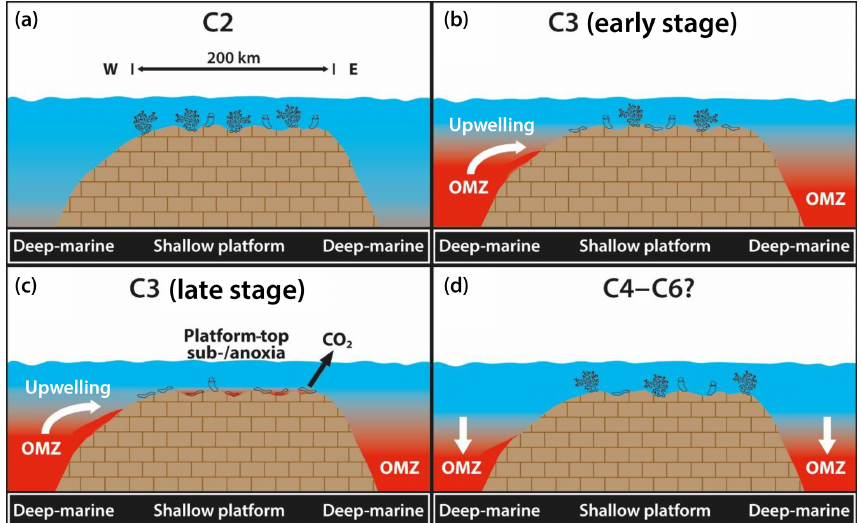
Figure 9. Chronology of Adriatic platform-top hypoxia subdivided in the chemostratigraphic segments C2 to C6 (?) according to Menegatti et al. (1998). (a) Normal marine oxygenated conditions with only localized microencruster facies but vital coral–rudist ecosystems. (b) OAE 1a-related oxygen depletion in basinal settings and deposition of organic-rich sediments (black shales) indicated by shift to low amounts of redox-sensitive trace elements in platform carbonates due to their sequestration into deep-marine black shales. Normal oxygenated conditions prevail on the platform top. (c) Platform-top oxygen hypoxia is established (Ce anomaly values and U isotope ratios) and coincides with the decline of coral–rudist facies accompanied by the expansion of microencruster facies. (d) Return of oxygenated platform-top water masses (Ce anomaly values and U isotope ratios) and the return of normal marine benthic biota. Redox-sensitive trace elements show a moderate increase, suggesting the decline of the oxygen minimum zone in basinal